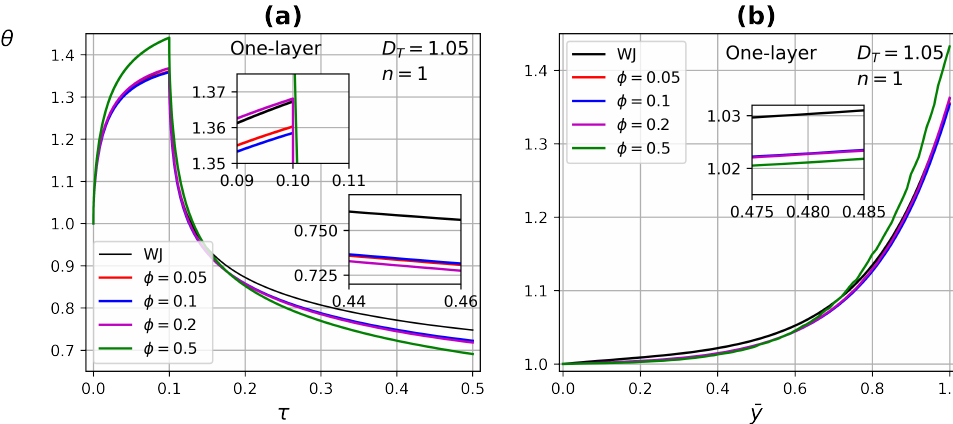
Figure 12. Temperature profiles as a function of ( a ) time and ( b ) tissue layer depth, for different porosity φ values at τ = 0.09.